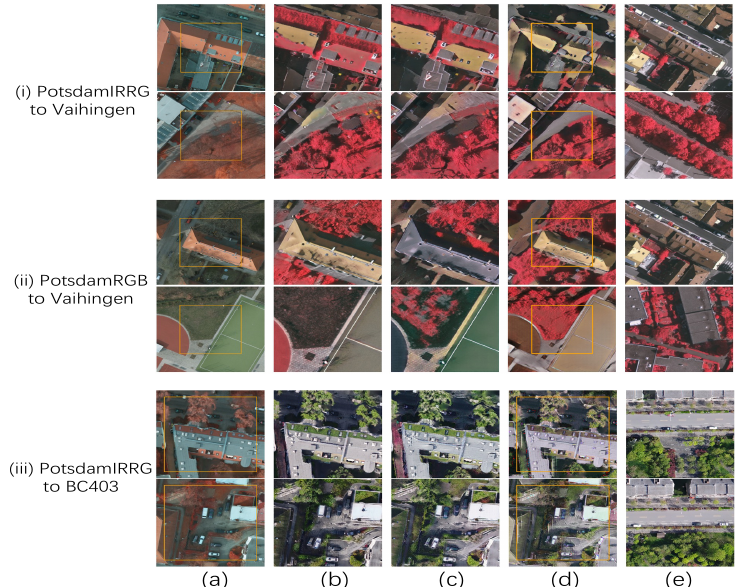
Figure 7. Results of image translation from (i) PotsdamIRRG to Vaihingen, (ii) PotsdamRGB to Vaihingen, and (iii) PotsdamIRRG to BC403. ( a ) Input images. ( b ) CycleGAN [24]. ( c ) DualGAN [33]. ( d ) ResiDualGAN. ( e ) Target images. The area within the orange rectangle in ( a , d ) is used for image translation in ( b , c ), where in (i) and (ii) the size of ( a ) is 896 × 896 and the orange rectangle of ( a ) is 512 × 512, as are the sizes of ( b – e ) to conform the Equation (1). In (iii), the size of ( a ) is 896 × 896 and the orange rectangle of (a) is 768 × 768, as are the sizes of ( b – e ).